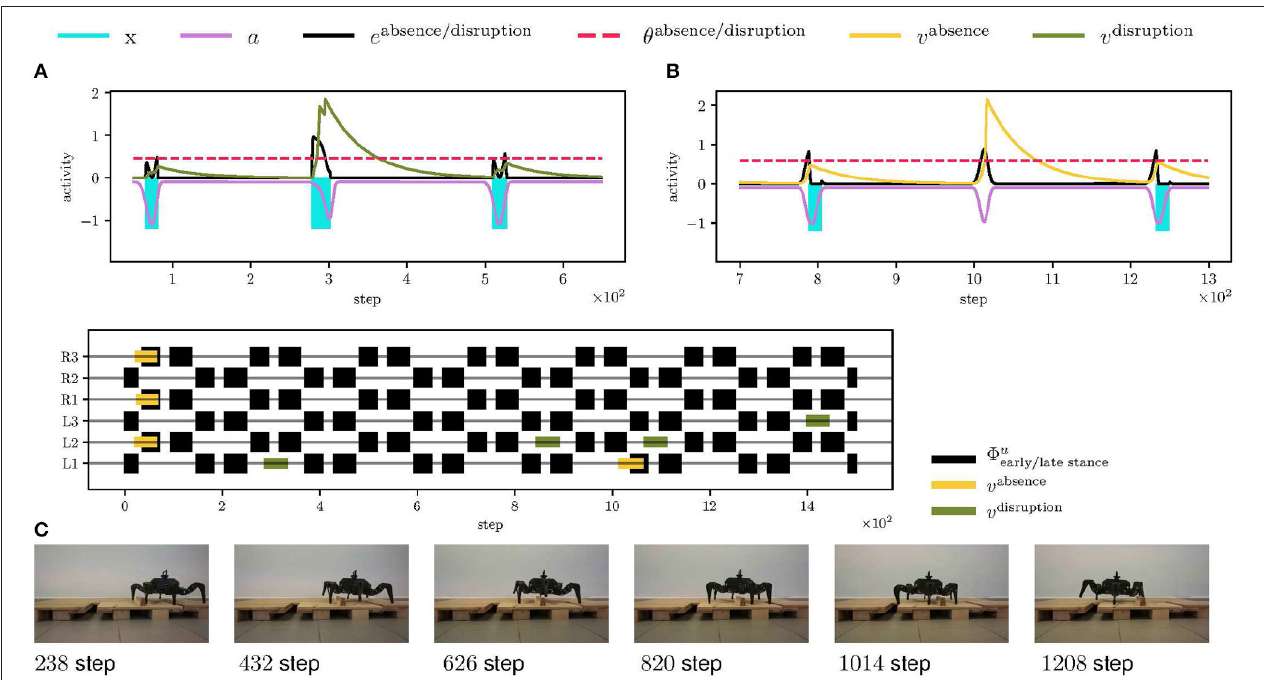
FIGURE 10 | Walking over obstacles deployment scenario. (A) At step 300, the front left leg (L1) encounters an obstacle, which stops the swing sooner, and thus the x stop event starts sooner, creating a high error e disruption (in the black). The error excites the LIF neuron activity (in the green) over the threshold (visualized as the dashed red line), thus the LIF fires triggering the elevator reflex on the L1 leg. (B) At step 1,000, the RBF neuron anticipates ground contact, which does not happen. The absence of the error excites the LIF neuron (in the yellow) and triggers the search reflex. (C) An overview of the triggered elevator (in the green) and search (in the yellow) reflexes for each leg. The black events show early and late stance phases. The left legs of the hexapod walking robot gradually detect and avoid the obstacle. At step 1,050, the front left leg steps into the depression, and the search reflex is triggered. Since there are no obstacles on the robot’s right side, no reflexes are triggered for the right